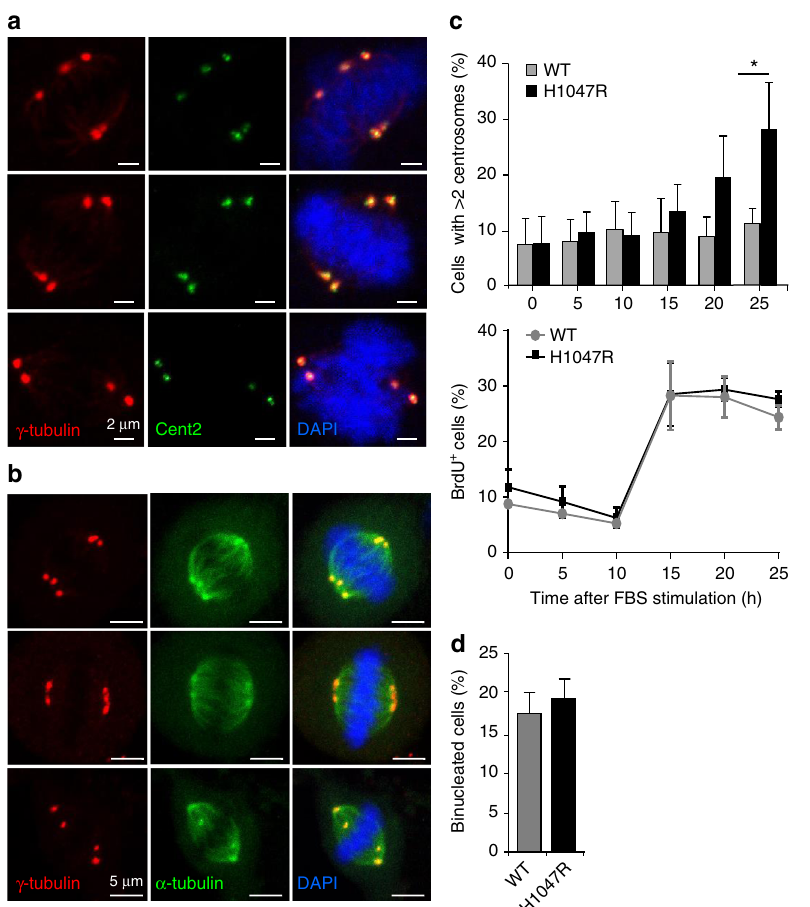
Fig. 3 p110 α H1047R expression in MEFs leads to centrosome overduplication. a Representative immuno fl uorescence images showing extra centrosomes in p110 α H1047R MEF cells composed of two centrioles. b Representative immuno fl uorescence images showing extra centrosomes contributing to the mitotic spindle in p110 α H1047R MEF cells. c Centrosome number during the fi rst cell cycle upon induction of p110 α H1047R expression (top panel; 200 cells per genotype and time point were scored for the centrosome analysis; values = mean ± SD) and parallel analysis of DNA synthesis (assessed by BrdU incorporation; bottom panel: 10,000 cells were acquired from two independent WT and two independent p110 α H1047R MEF lines. Statistically signi fi cant differences are indicated by *( P < 0.05), as determined by non-parametric Mann – Whitney t test (one-tailed). MEFs were plated and cultured overnight in serum-containing medium. The next morning, cells were serum-starved in the presence of 4-OHT for 48 h, followed by re-addition of 10% fetal bovine serum and sampling of cells at the indicated time points. d Percentage of binucleated MEFs in cultures treated 2 days with 4-OHT. Binucleation was assessed by IF using DAPI to stain DNA. A total of 200 cells were scored per genotype in 3 Pik3ca WT ; Flpe-ER T2 and 3 Pik3ca H1047R+neo ; Flpe-ER T2 independent MEF lines (values = mean ±